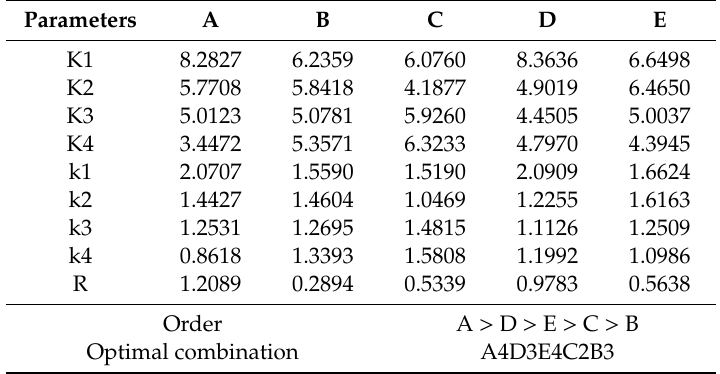
Table 3. Analysis of the results using range method for the uniformity of internal mixing nozzle.